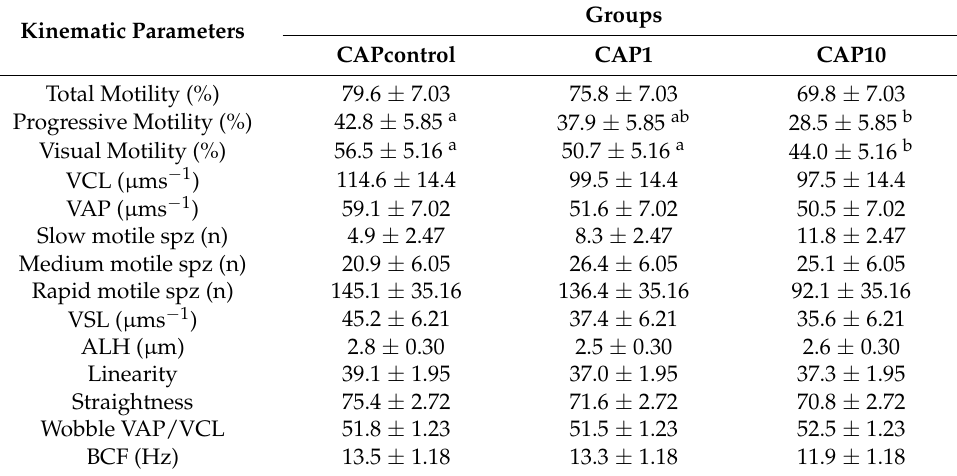
Table 1. Evaluation of the effect of AntiOxBEN2 on the kinematic parameters of semen using Computer Assisted Sperm Analysis (CASA) software and visual observation (6